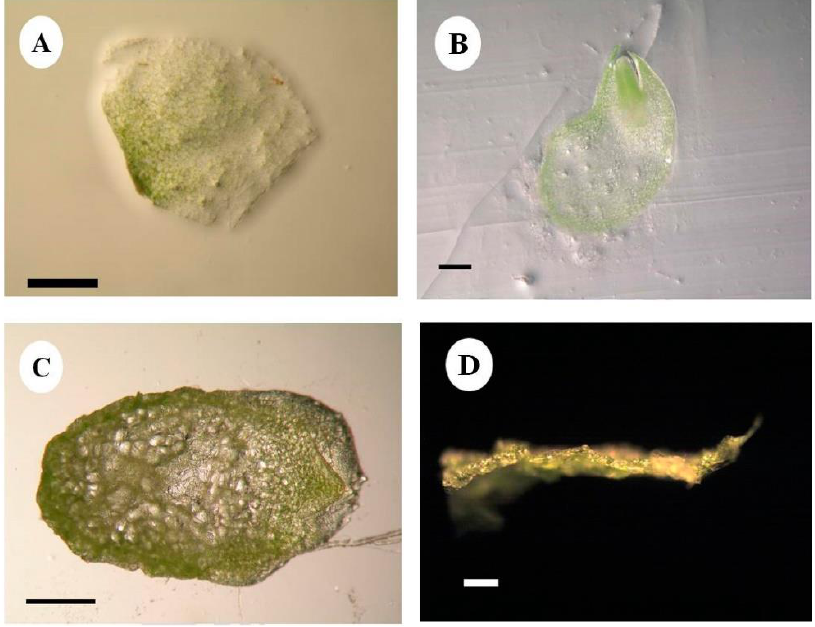
Figure 1. Different tTCL thicknesses of PLB sections generated by microtome: ( A ) 100 μm ; ( B ) 200 μm ; and ( C ) 300 μm. ( D ) is the side view of the 100 μm section as measured using a 0.01 m calibration and ( C ) 300 µ m. ( D ) is the side view of the 100 µ m section as measured using a 0.01 m calibration plate under a microphotography system (bar = 100 μm). plate under a microphotography system (bar = 100 µ